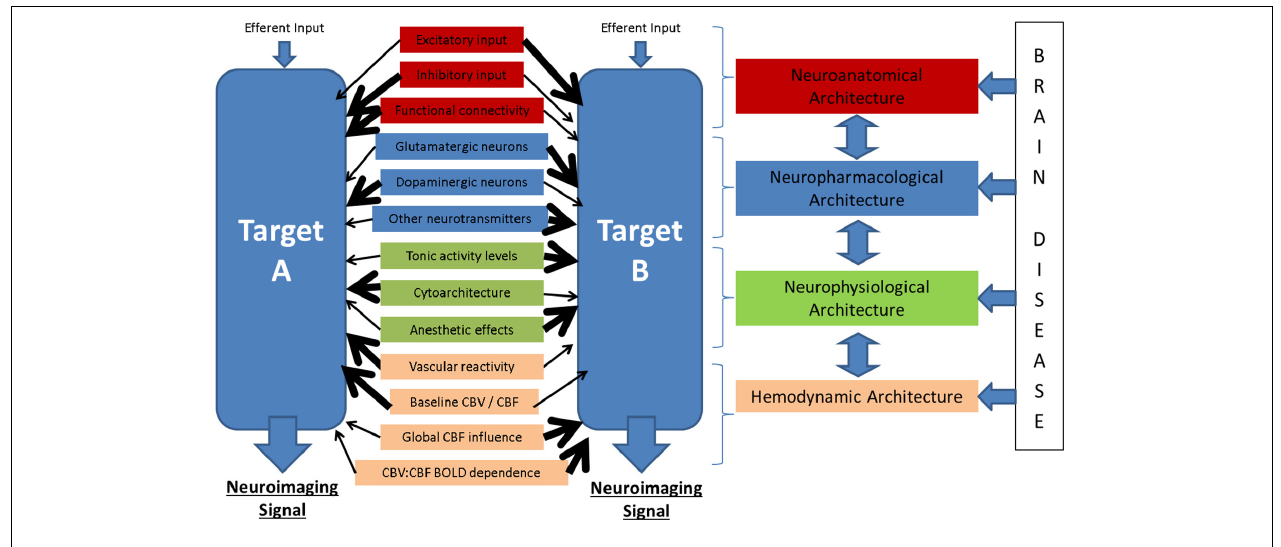
FIGURE 6 | Potential modulators of the neuronal-neuroimaging signal relationships illustrated in Figure 1. When considering two neuroimaging targets, which may be: (1) different brain regions, (2) the same region in different subjects, (3) the same region in the same subject at different time